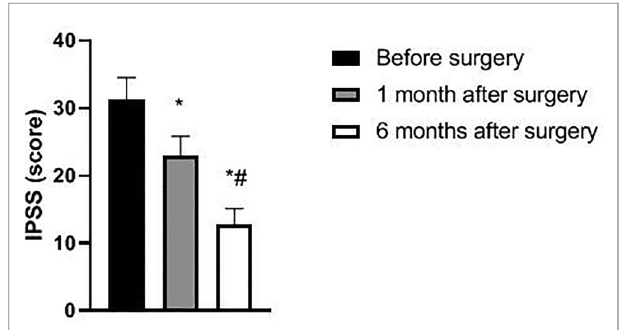
FIGURE 1 | Changes in IPSS of patients before and after surgery.